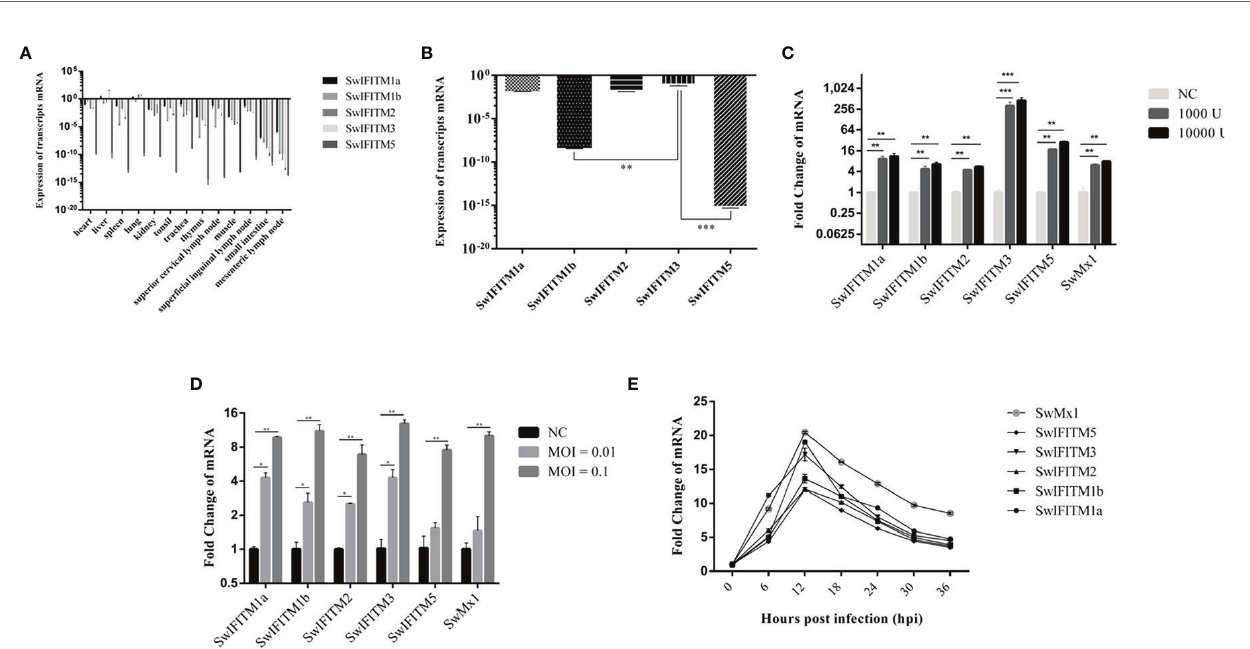
FIGURE 1 | The expression level of SwIFITMs. (A) Expression levels of SwIFITMs in different porcine tissues were normalized by b -actin mRNA. (B) Expression levels of SwIFITMs in PAMs were normalized by b -actin mRNA and SwIFITM3 served as a control. (C) Expression levels of SwIFITMs in PAMs after treatment with IFN- a for 24 h were compared with untreated PAM mRNA, Mx1 served as a control. (D) Expression levels of SwIFITMs in PAMs after being infected with ASFV for 24 h were compared with untreated PAM mRNA. (E) Expression levels of SwIFITMs in PAMs after being infected with ASFV (0.1 MOI) each 6 h from 0 to 36 hpi. All samples were analyzed in triplicate, and three independent experiments were performed. * p <0.05; ** p <0.01; *** p <0.001 vs negative control group. Error bars indicate standard